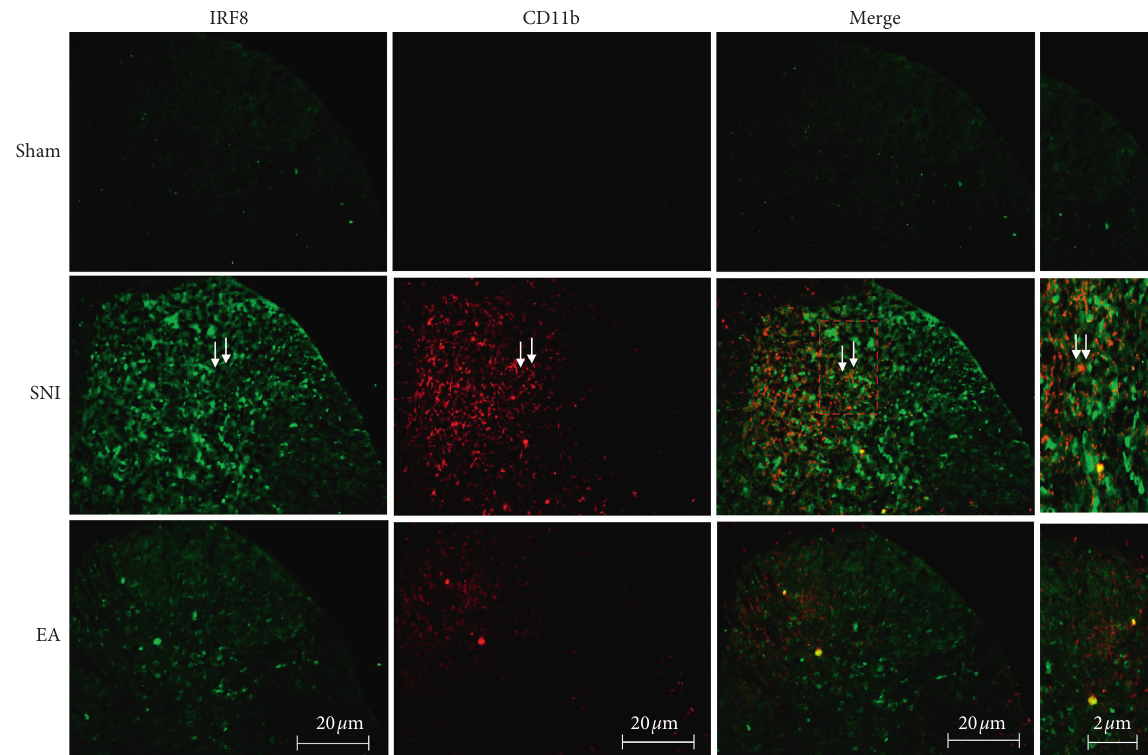
Figure 4: Immunofluorescence staining detected the effect of 2Hz EA on coexpression of spinal IRF8 with CD11b in SNI rats. IRF8 and CD11b were double-stained in the spinal dorsal horn from the sham, SNI, and SNI +EA group rats (scale bar � 20 μ m). Immunofluo- rescence staining results showed that SNI enhanced spinal IRF8 and CD11b expression compared with the sham group. 2 Hz EA treatment reversed the coexpression of IRF8 (green) with microglial activation indicator CD11b (red) in the spinal cord of SNI